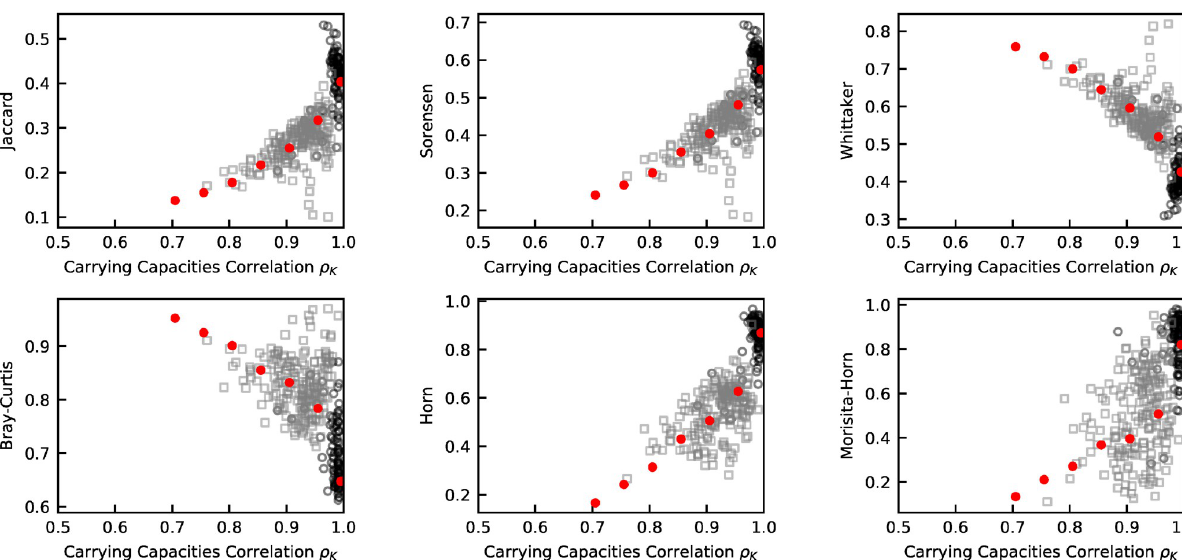
Fig 3. Comparison between the relationships between dissimilarity measures in empirical data and according to the model. The different dissimilarity measures (A: Jaccard similarity, B: S ø rensen index, C: Whittaker index D: Bray-Curtis disimilarity, E: Horn similarty, F: Morisita-Horn similarity) are plotted against the carrying capacity correlation ρ . Black circles correspond to pairs of empirical samples from the same host, while grey K squares correspond to pairs of empirical samples from different hosts (but of the same dataset). The value of ρ K for individual samples is inferred as specified in the Methods. Red dots are the binned average of the predictions of the model. The model is simulated with the distributions of K and σ fitted from the data, and with a number of species equal to the one estimated (see Section B in S1 Text). The number of reads is equal to the average number of reads for the empirical samples, 3 � 10 4